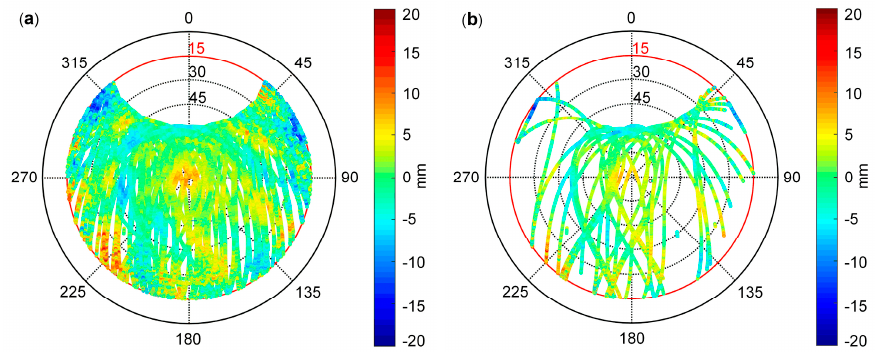
Figure 7. ( a ) SD-MHM model established by DOY 296–302; and ( b ) the distribution of DOY303 single-difference residuals.